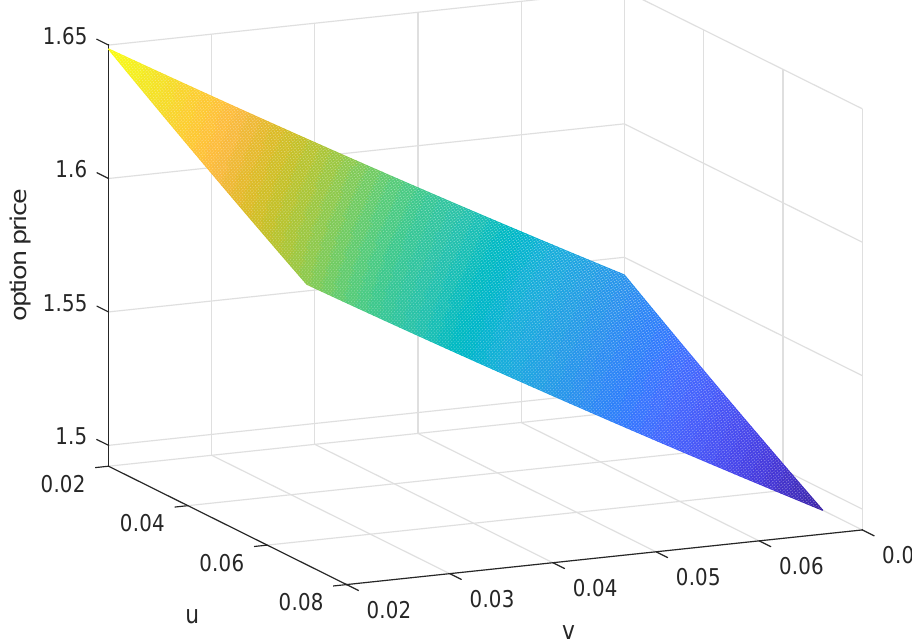
Figure 6. The price of the option with different u , v in [ 3.5,5.5 ] while p = 1.9, K = 4.5. As is shown in Figure 6, price f was a decreasing function of both u and v . In Function (20), taking derivatives in u and v , the decrease was nonlinear. In addition, as u and v increased simultaneously, the value of price f